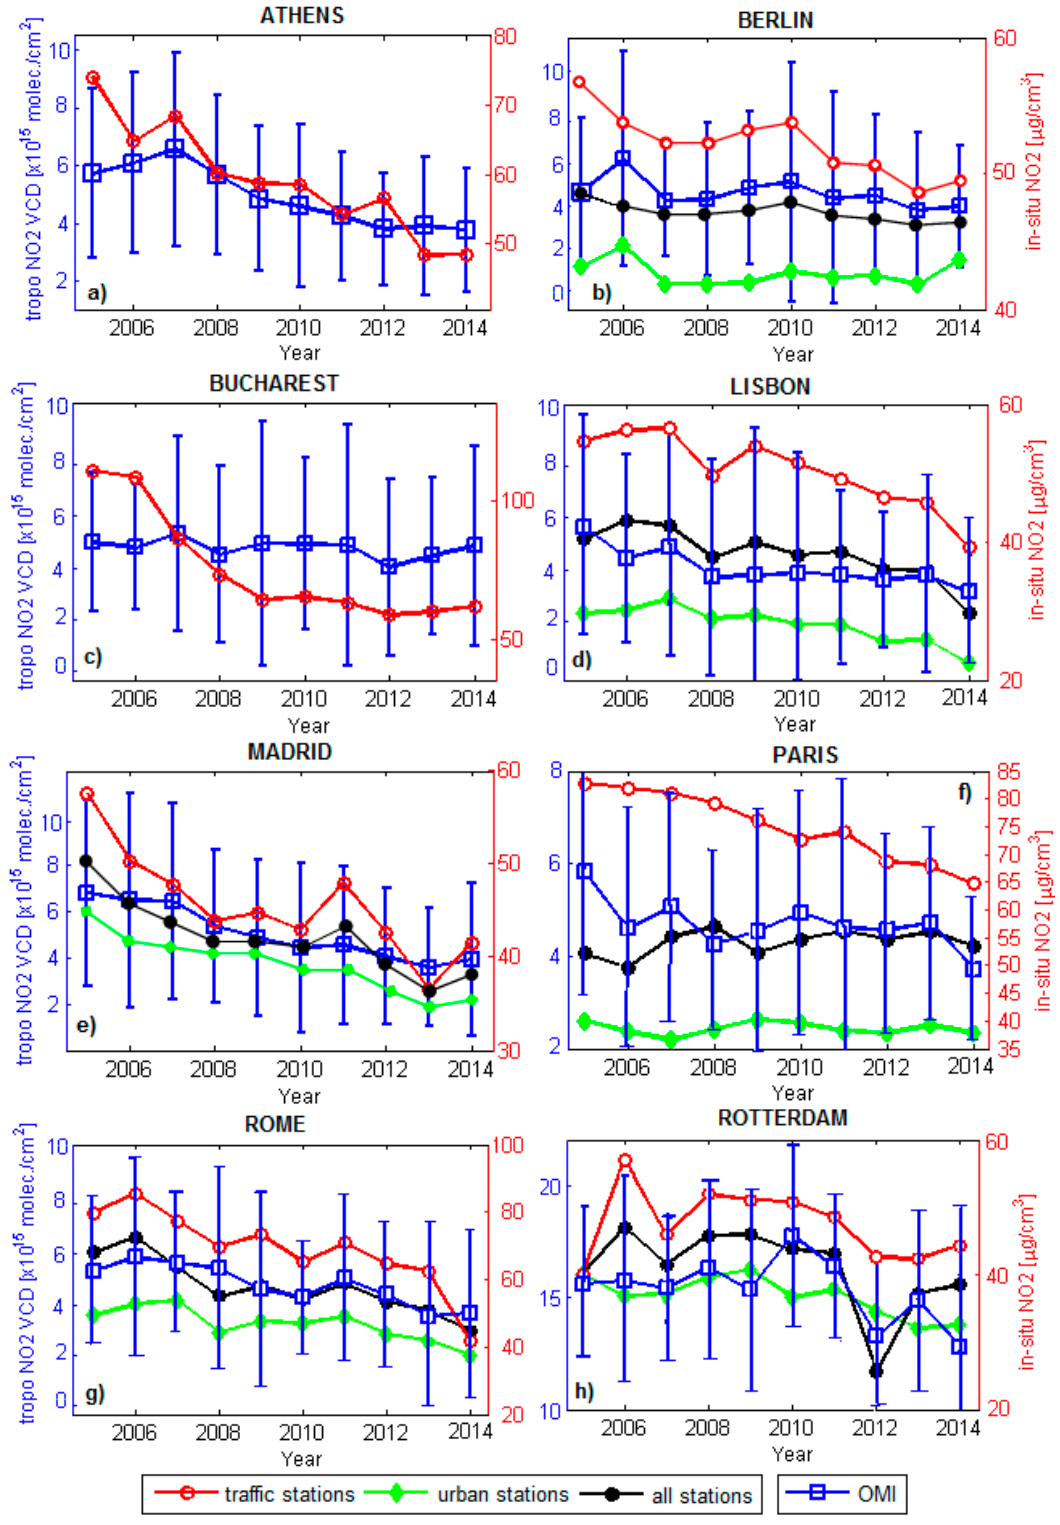
Figure 2. The time series of NO 2 concentration from urban and traffic stations, including OMI NO 2 observations for the selected cities: ( a ) Athens, ( b ) Berlin, (c) Bucharest, ( d ) Lisbon, ( e ) Madrid, ( f ) Paris, ( g ) Rome, ( h ) Rotterdam. “All stations” represents the average of traffic stations and urban stations.